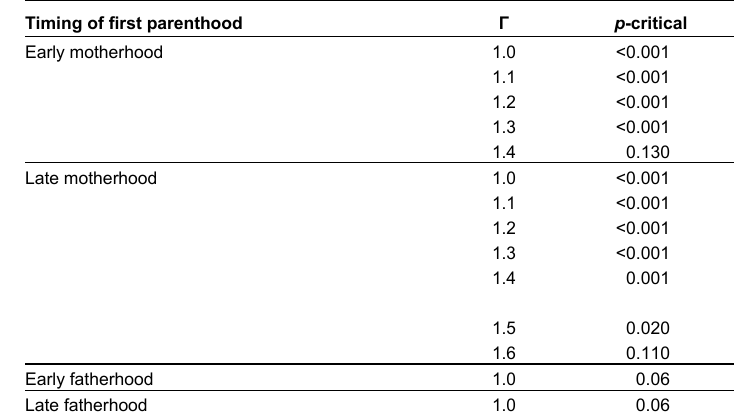
A sensitivity analysis using the Rosenbaum bounds of the causal effects of timing of first parenthood, by sex and timing Timing of first parenthood Γ p -critical Early motherhood 1.0 <0.001 Late motherhood 1.0 <0.001 Early fatherhood 1.0 0.06 Late fatherhood 1.0